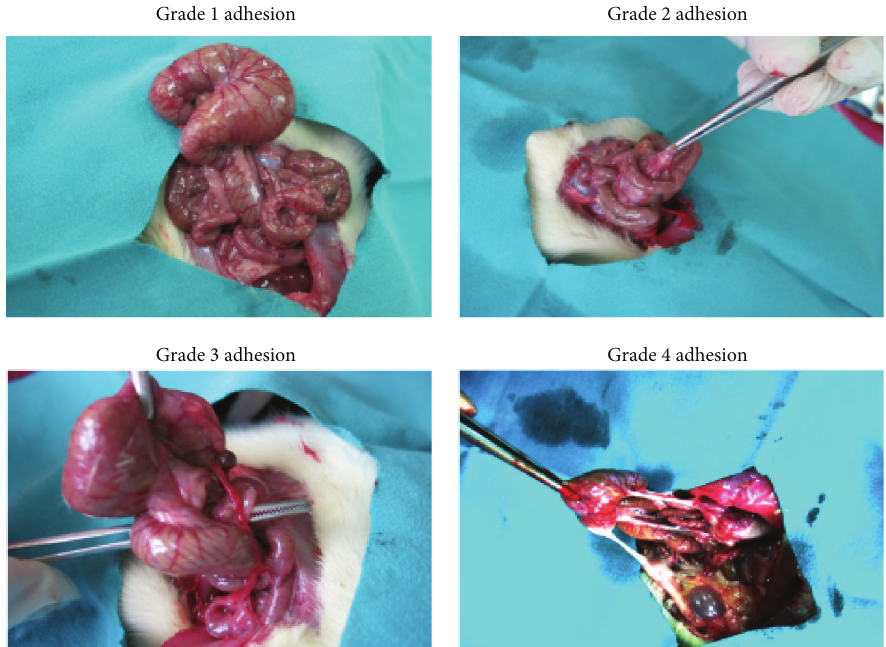
Figure 1: Macroscopic scoring of